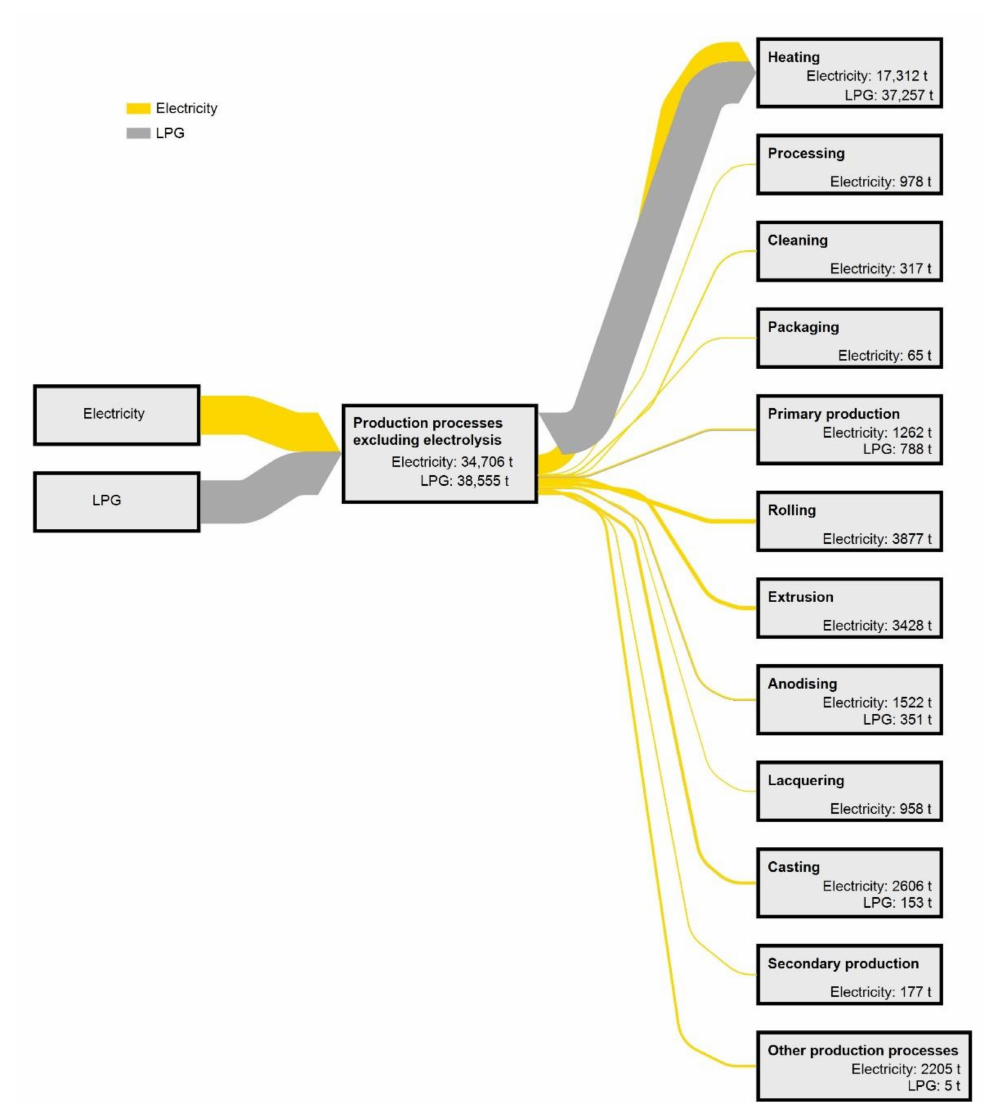
Figure 11. The GHG emissions of the aluminium industry and two aluminium casting foundries in Sweden regarding production processes, divided into each main category. Electrolysis is excluded. Processes occurring at several companies in the supply chain have been combined into one entry each. The average mix perspective and the emission factors in Table 1 were used here, as described in Section